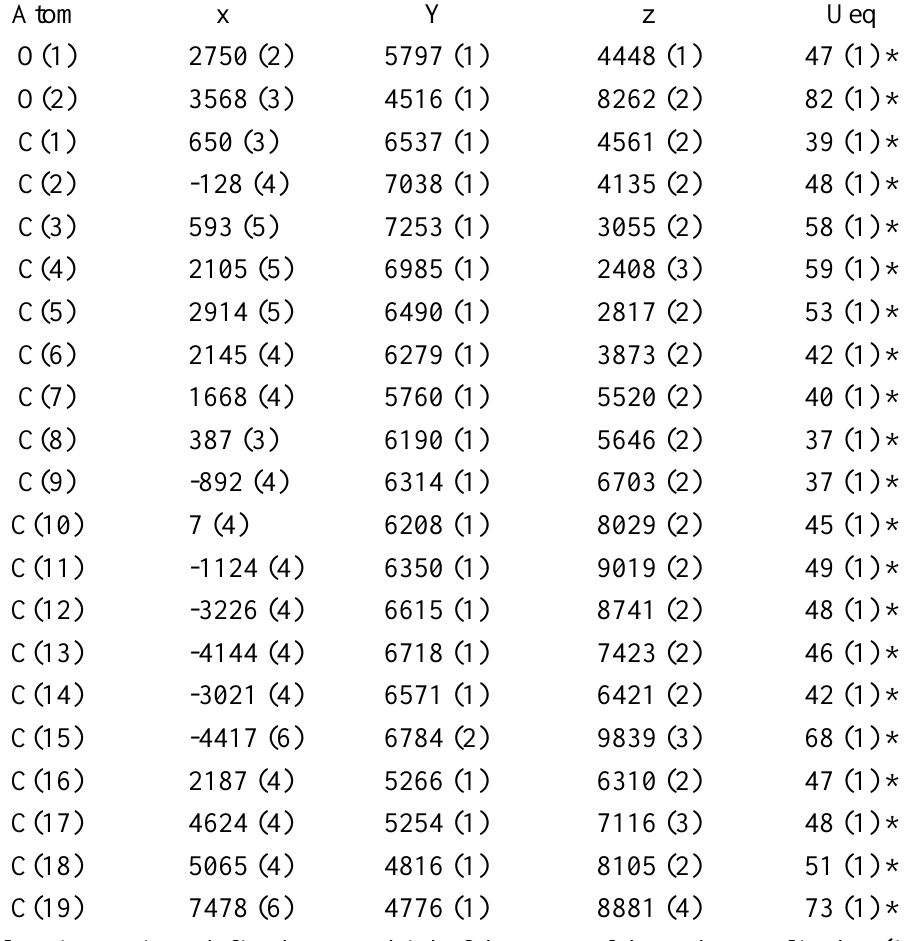
Table 6. Atom coordinates ((cid:31) 10 4 ) and temperature factors (A 2 (cid:31) 10 3